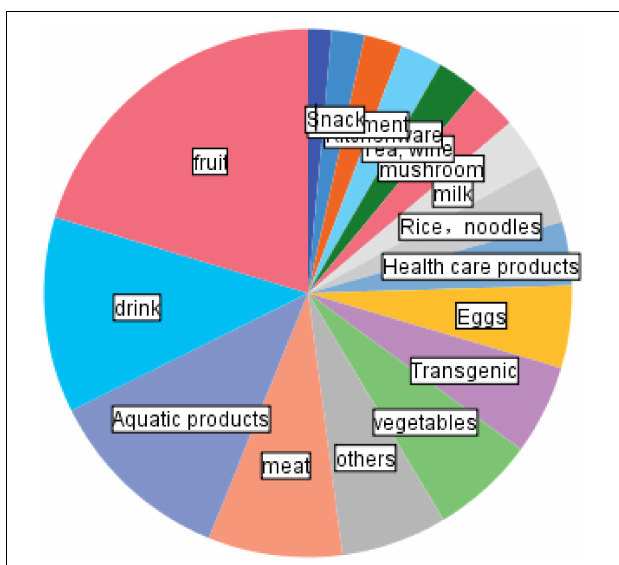
FIGURE 4 | Food rumour